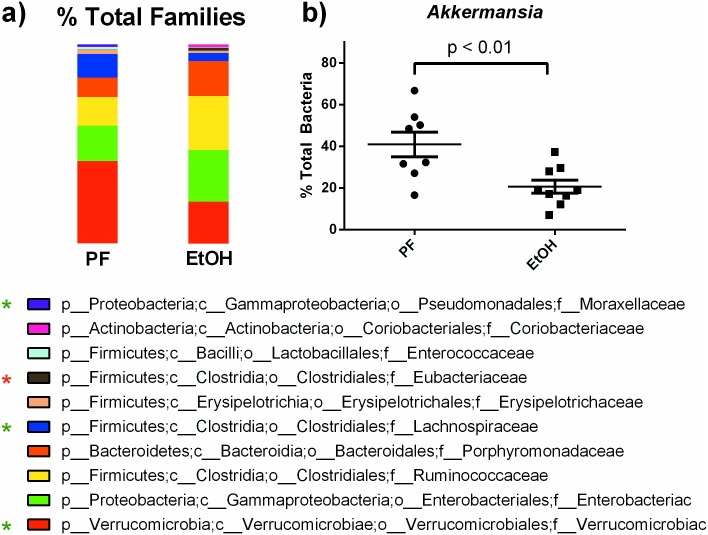
Alcohol alters family-level community representation in some of the nine most abundant bacterial families.(a) To represent a subset of the bacterial composition in cecal content of pair- and alcohol-fed mice, we chose the nine most abundant families, each comprising >0.5% of all families. Those differentially enriched in pair-fed mice are indicated by a green asterisk; red asterisk denotes families enriched in alcohol-fed mice. (b) The genus Akkermansia represented 100% of the family Verrucomicrobiacea, the most abundant family found in pair-fed mice, and was significantly reduced by alcohol administration. The prefix letter followed by an underscore represents the taxonomic level (e.g. “p_” for phylum, “c_” for class, etc.). * p<0.05 by Mann-Whitney test.